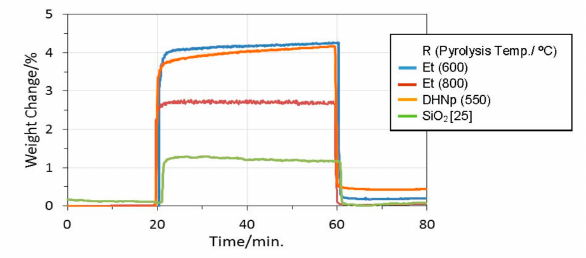
Figure 13. CO 2 capture capacity vs. SSA of ROSZ-derived amorphous Si–O–N samples.